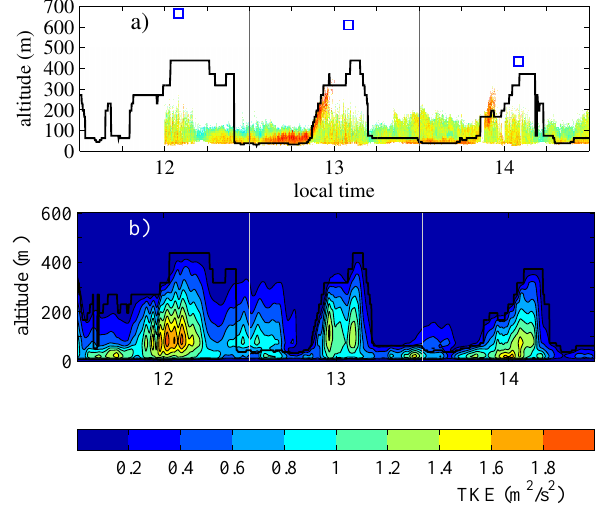
Fig. 1. (a) Mixing height (i) as observed by SODAR, shown by colours, red colour shows the strongest echo and thereby the alti- tude of temperature inversion, see Lauros et al. (2007), and (ii) as determined from radiosonde measurements in Jokioinen, 100km to the South from SMEAR II, shown by blue squares, and (iii) as sim- ulated with MALTE, shown by black curve. (b) Turbulence kinetic energy (TKE) from simulations, black curve same as in (a) .